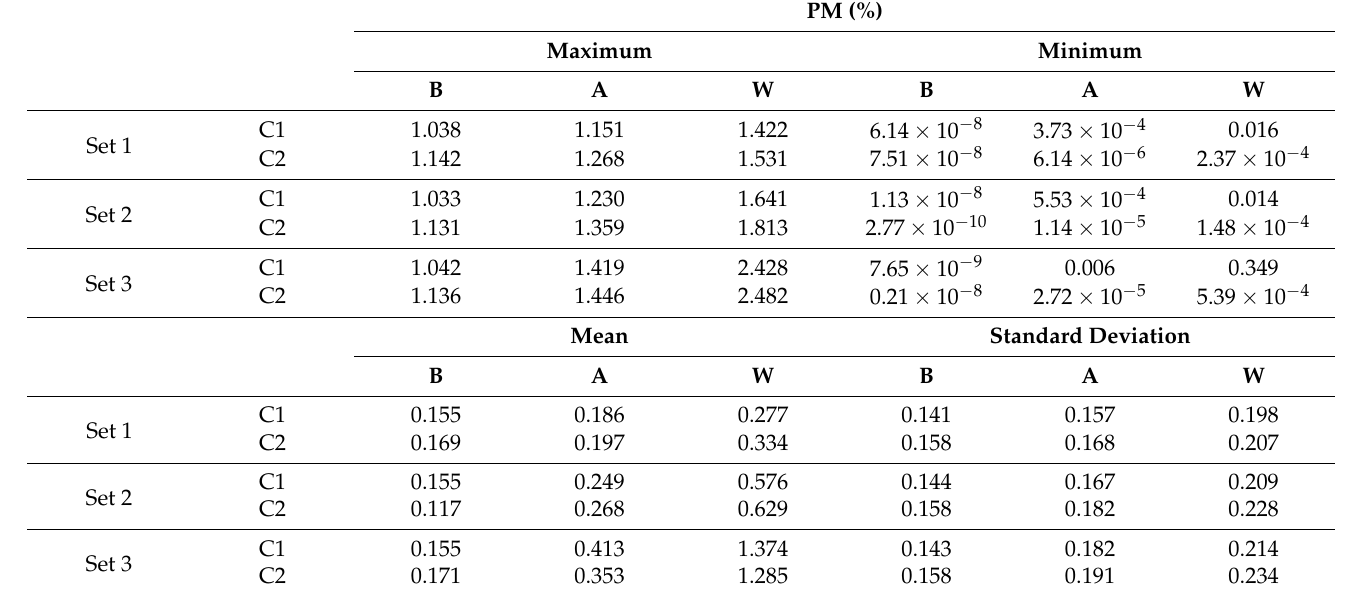
Table 5. Monte-Carlo simulation results in terms of PM% index. Letters B, A and W stand for best, average and worst values,